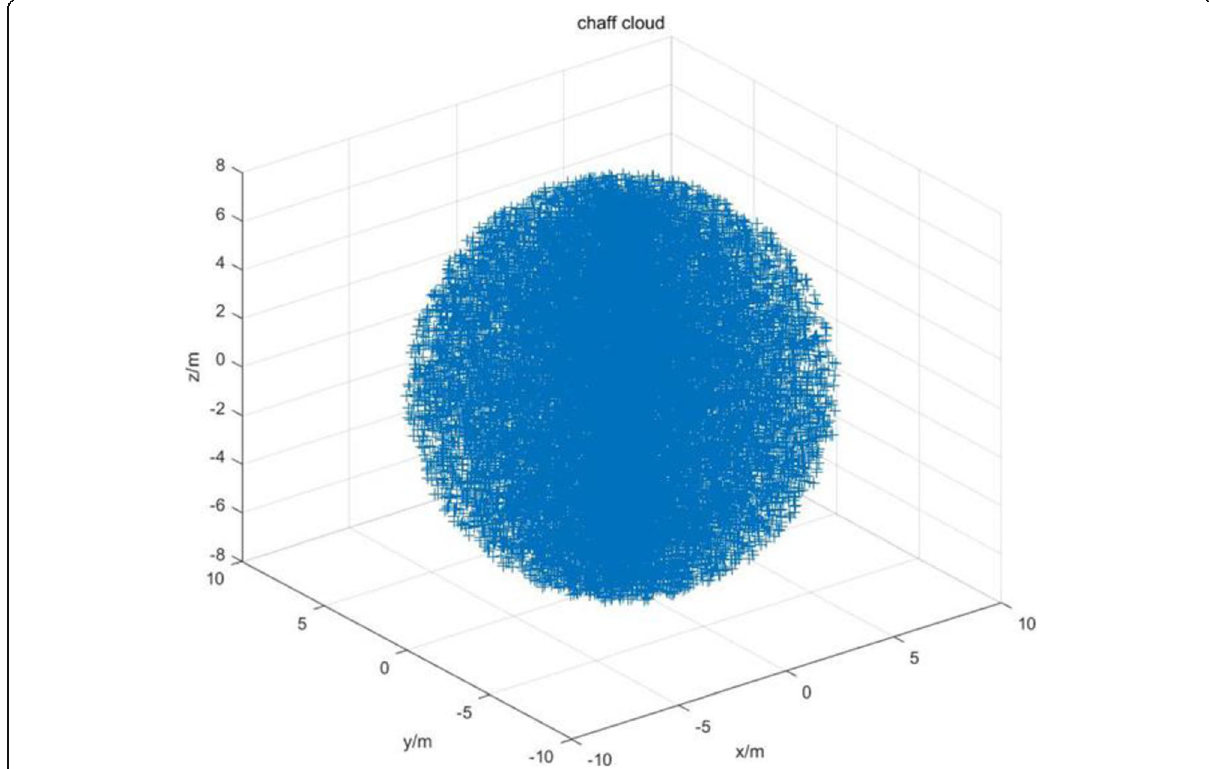
Fig. 3 A solid spherical steady-state model of the chaff